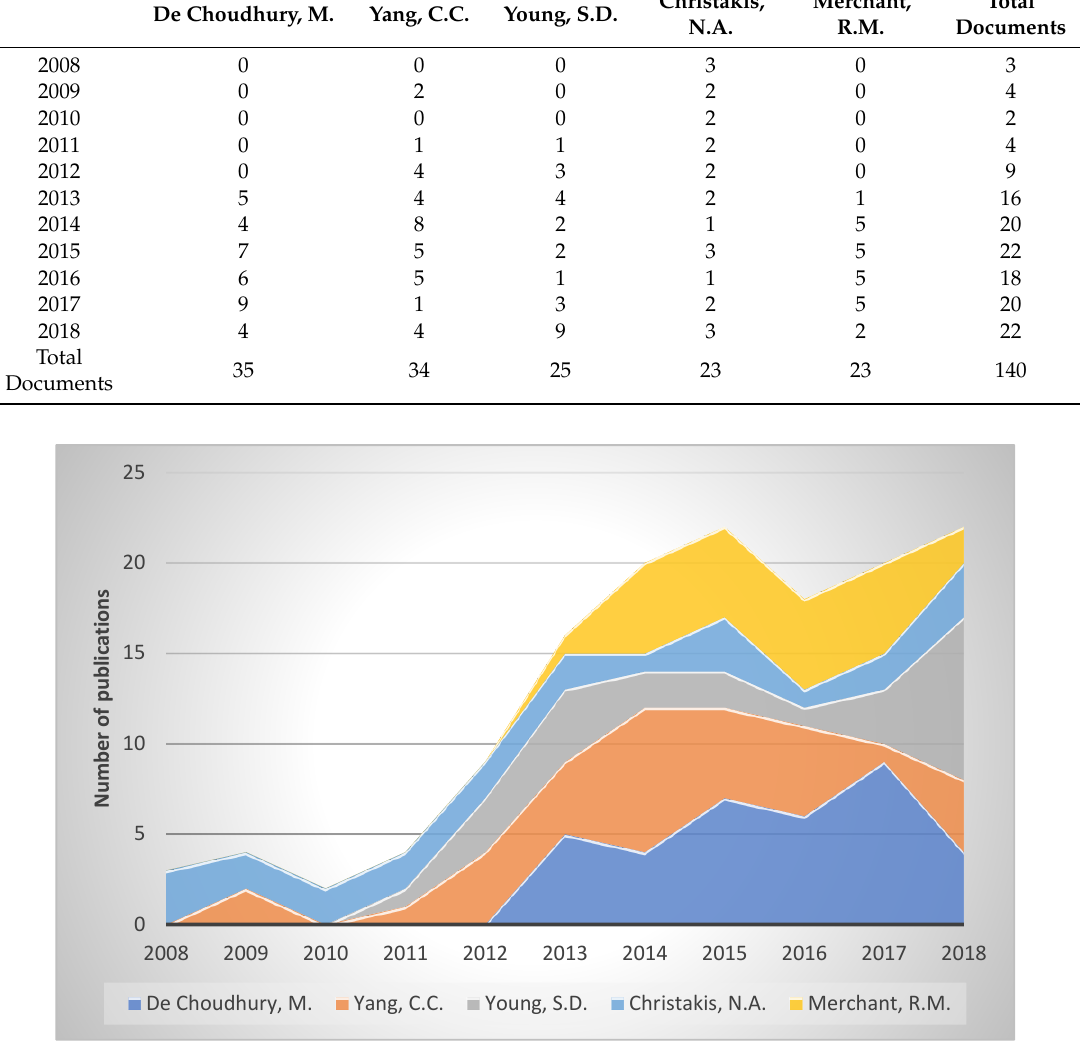
Figure 9. The top principal authors of the last decade.